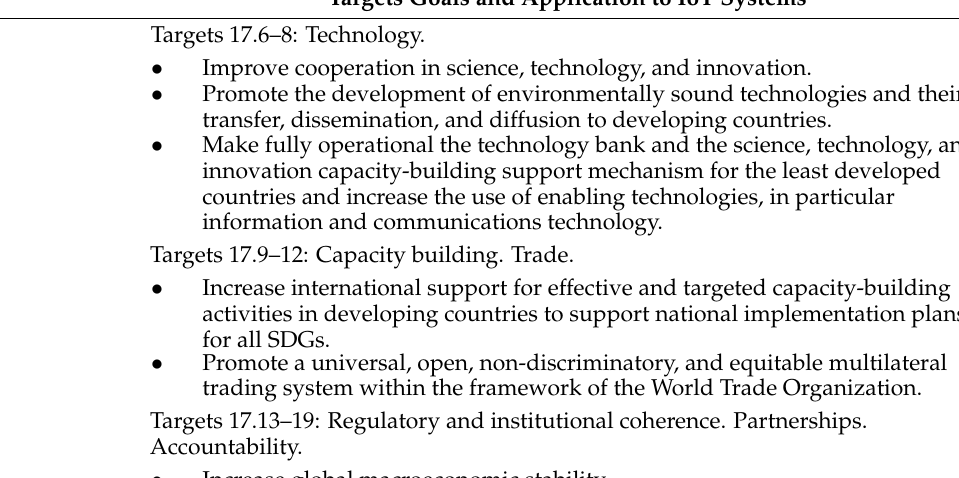
Table 5. Impact of the Sustainable Development Goals on IoT applications for improving health and the environment. SDGs Targets Goals and Application to IoT